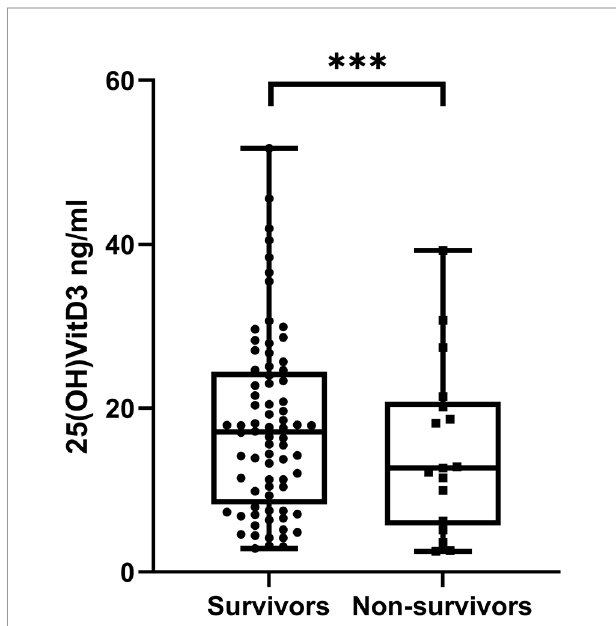
FIGURE 4 | Difference in 25OHD levels between survivors and non-survivors patients. ***p < 0.0001.